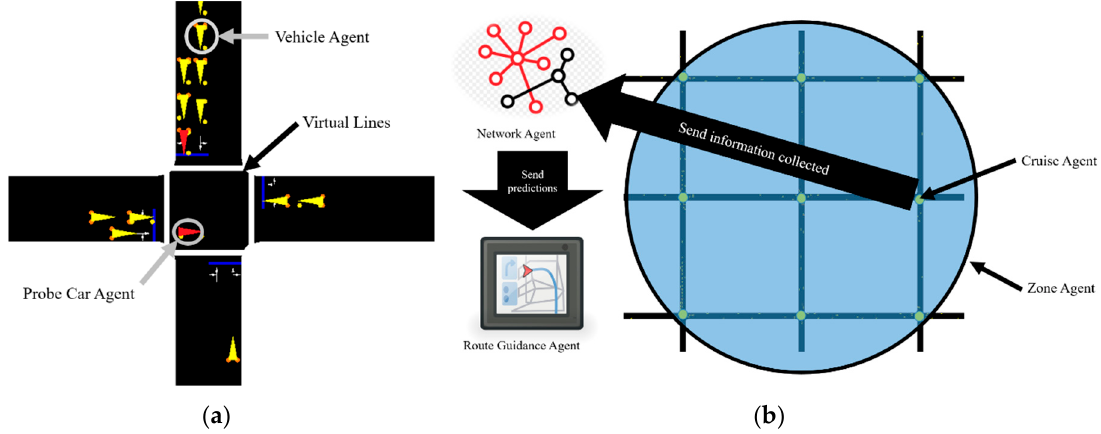
Figure 1. ( a ) As soon as a Probe Car Agent crosses an intersection, it sends to the Cruise Agent the status of that street; ( b ) the Cruise Agent transmits to the Network Agent, who makes the prediction.